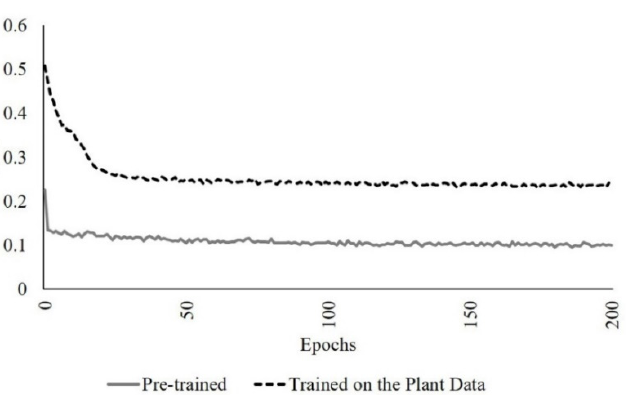
Figure 8. PointCleanNet outlier removal architecture; ℙ′ , ℙ(cid:3553) , and 𝕆(cid:3561) denote a dataset contami- nated with outliers as input, the dataset after outlier removal, and outliers, respectively. FCN and (Q)STN are the Fully Connected and (Quaternion) Spatial Transformer Networks. The input is a patch point, and output is a label for each point related to its status as an outlier [22].